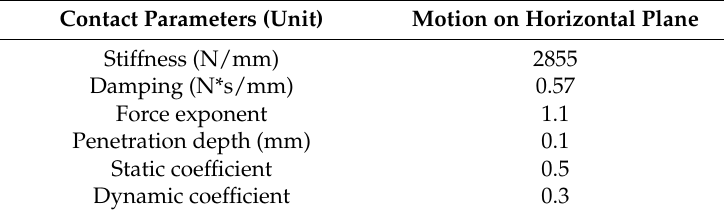
Table 2. Contact parameters between the feet and the ground.